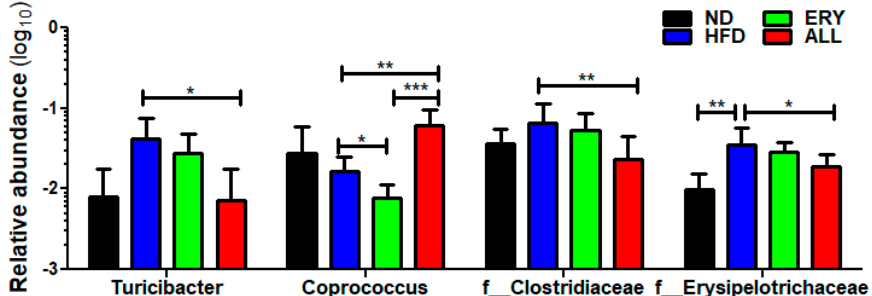
Figure 5. Effects of 16-week D-allulose supplement on microbiota modulation. Relative abundance of Turicibacter , Coprococcus , Clostridiaceae and erysipelotrichaceae ; Kruskal-Wallis test; * p < 0.05, ** p < 0.01, *** p < 0.001 versus control; ND, normal diet; HFD, high-fat diet (20% fat, 1% cholesterol); ERY (HFD + 5% Erythritol); ALL, (HFD + 5% D-allulose).